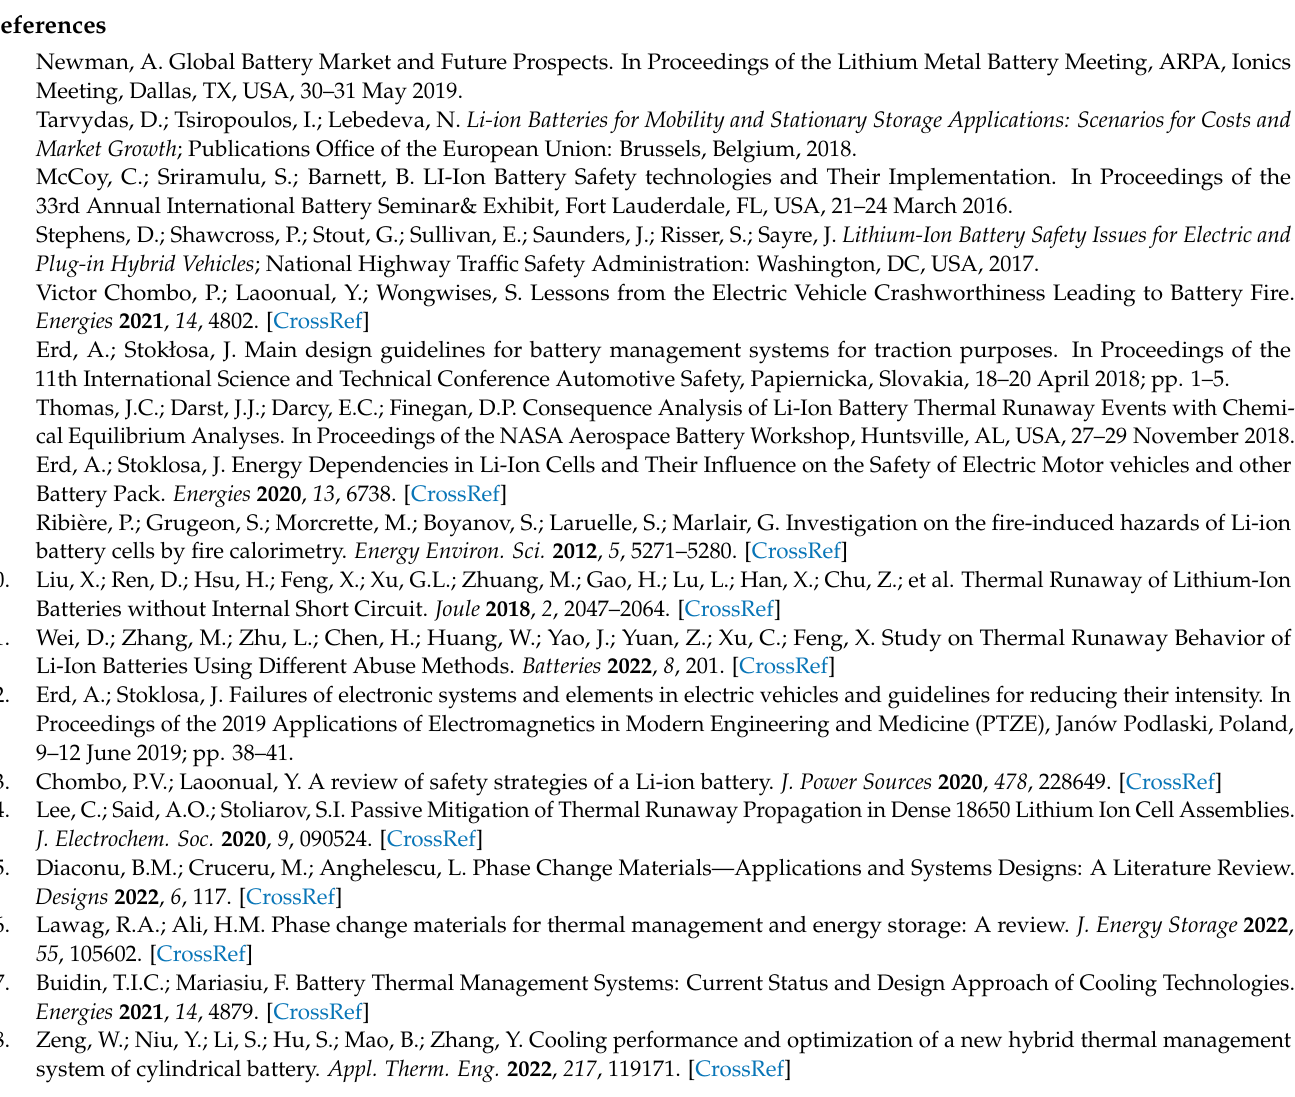
Figure A1. The dependence of the brass model temperature on the energy supplied to the cell module. (Energy supply power: constant and equal to 9 W).